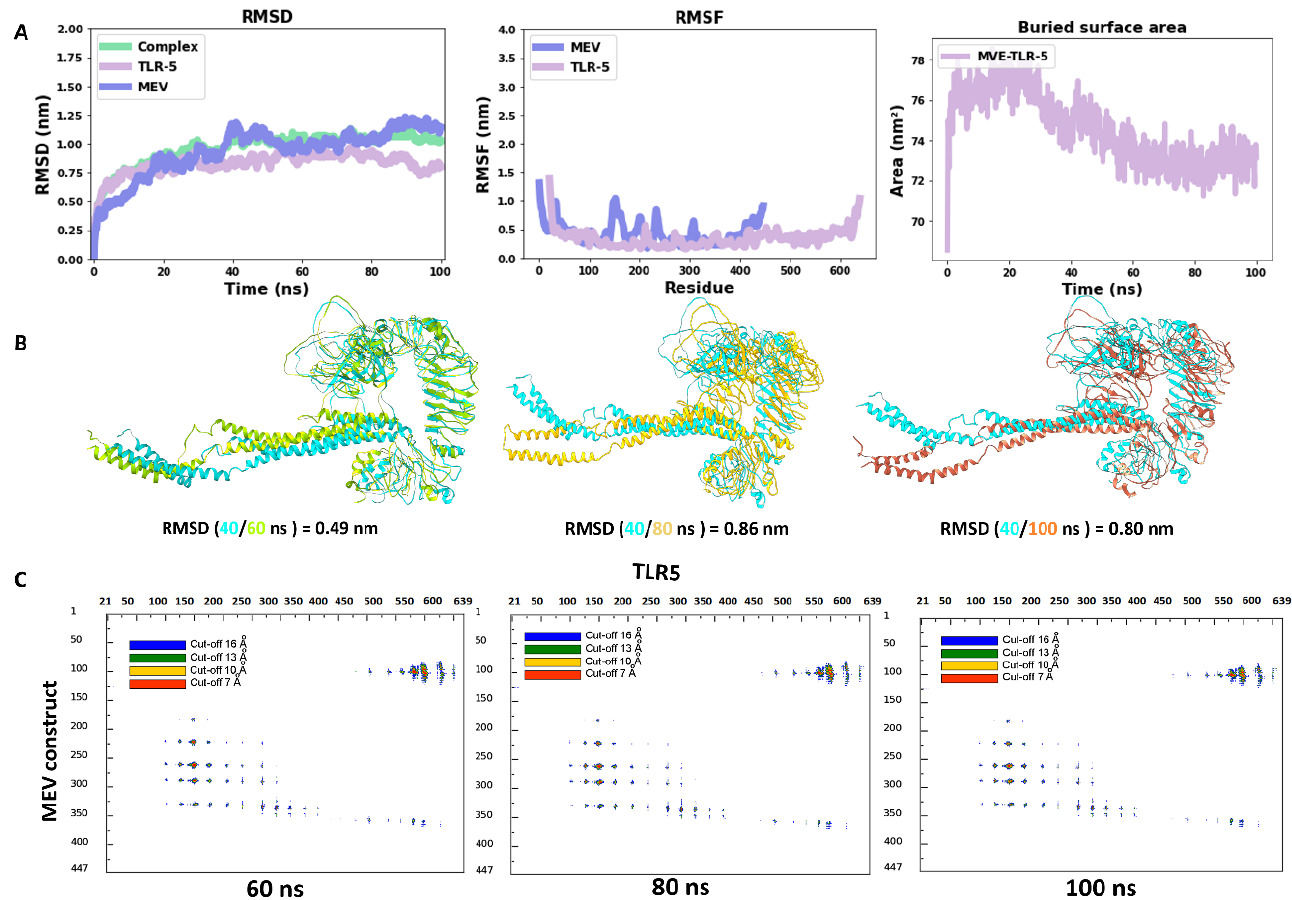
Figure 3. ( A ) Time evolution of the backbone RMSD of the TLR5, MEV constructs and their complex during MD simulations, backbone RMSF plots, buried surface area; ( B ) superimposition of snapshots of TLR5 and MEV constructs with their respective RMSD values; ( C ) contact maps showing inter-molecular contacts where the dots at the crossover of two amino acids have been colored in red, yellow, green, and blue if any pair of atoms between two amino acids was closer than 7, 10, 13, or 16 Å .